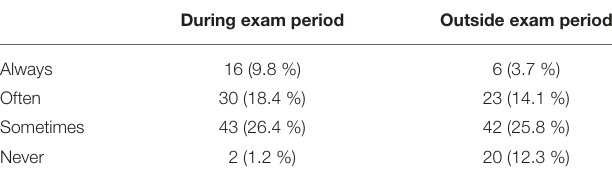
TABLE 2 | Appearance of mental images during and outside the exam time. During exam period Outside exam